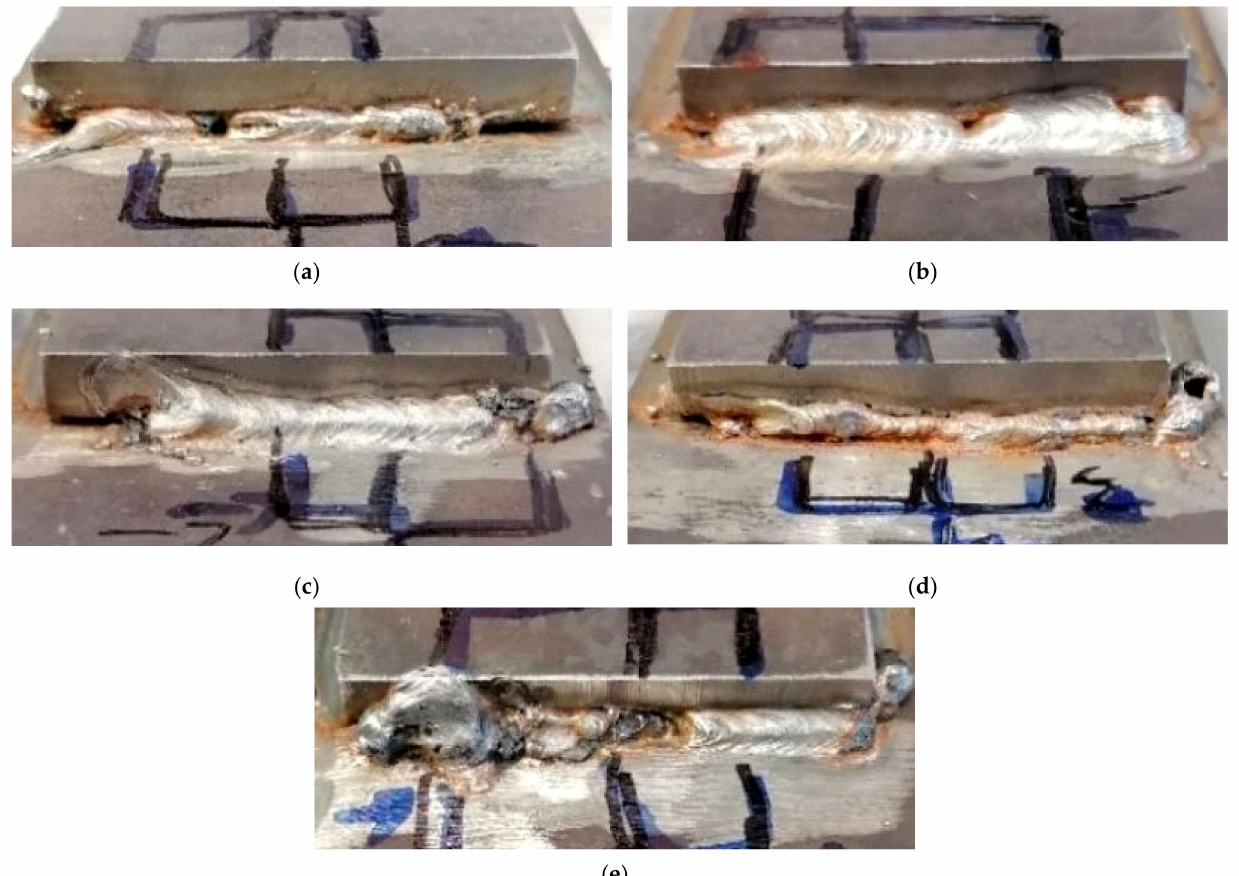
Figure 2. The exemplary results of the visual test (VT): ( a ) weld 1—specimen 1 (non-modified electrode), pores, weld length 60 mm; ( b ) weld 2—specimen 2 (underwater electrode), weld length 70 mm; ( c ) weld 1—specimen 3 (concrete impregnate), spatter, weld length 60 mm; ( d ) weld 2—specimen 4 (liquid foil), lack of fusion, undercuts, shape defects, weld length 70 mm; ( e ) weld 1—specimen 5 (paraffin wax), shape defects, pores, weld length 70